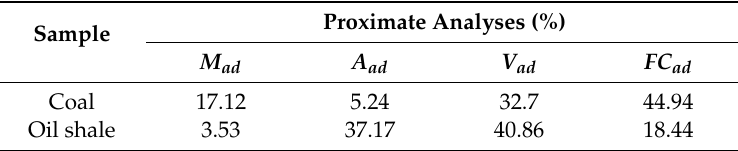
Figure 1. Particle size distributions of oil shale dust sample versus coal dust sample: ( a ) coal dust; ( b ) oil shale. Table 1. Proximate analyses of the coal and oil shale.